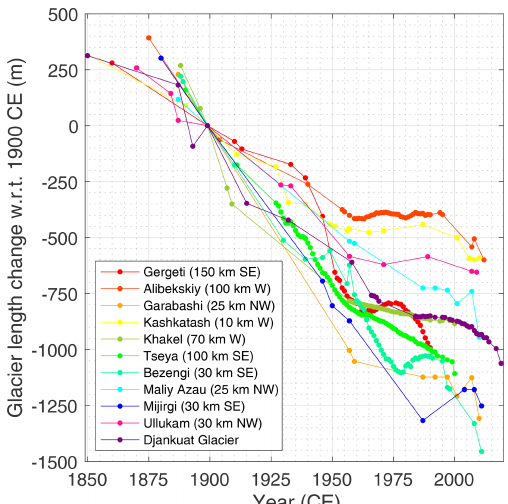
Figure 3. Historic length variations of the Djankuat Glacier compared to other glaciers in the Caucasus (Solomina et al., 2016; WGMS, 2018). Approximate distances and direction to the Djankuat Glacier are